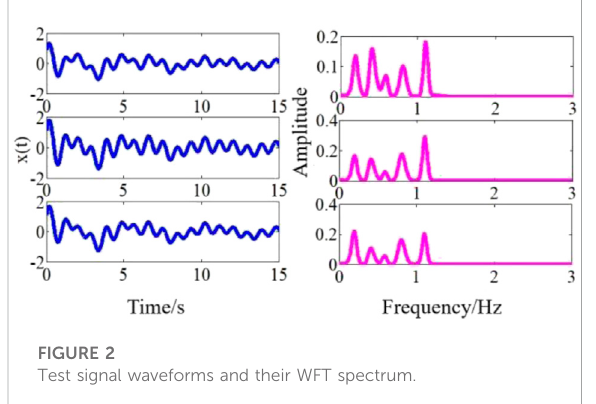
FIGURE 2 Test signal waveforms and their WFT spectrum.